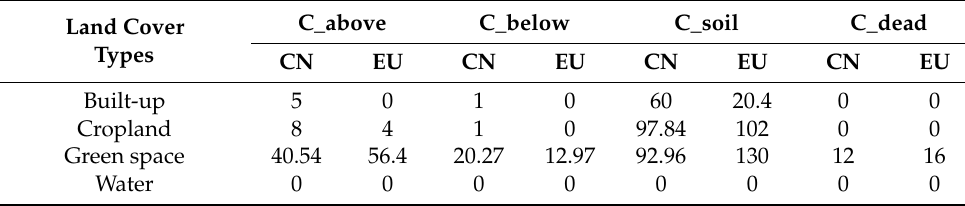
Figure A7. Total PM 2.5 removal for different development areas of six cities from 2000 to 2030. Table A1. Carbon density of four pools in different land use types. (Unit: t/ha).